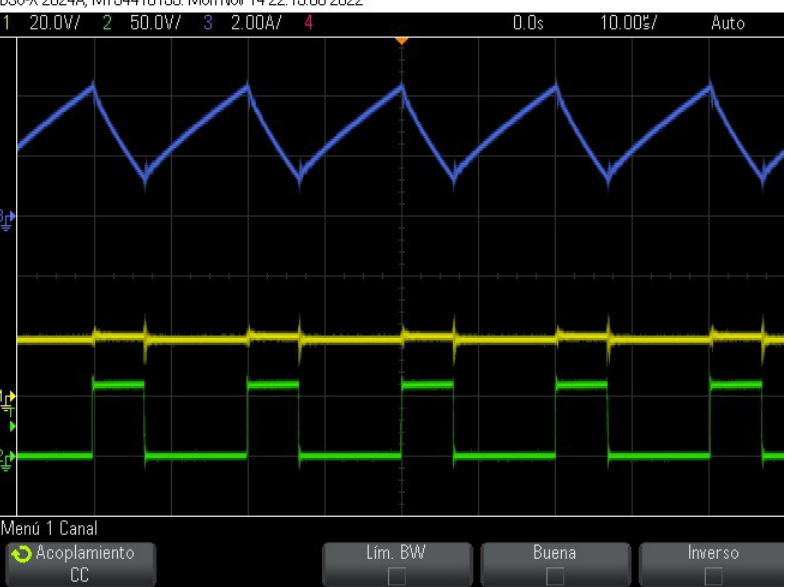
Figure 14. From the top to the bottom: input current I g (blue trace), input voltage V g (yellow trace), and terminal voltage of transistor ¯ s 1 = 60 V (green trace) of the DDSB power